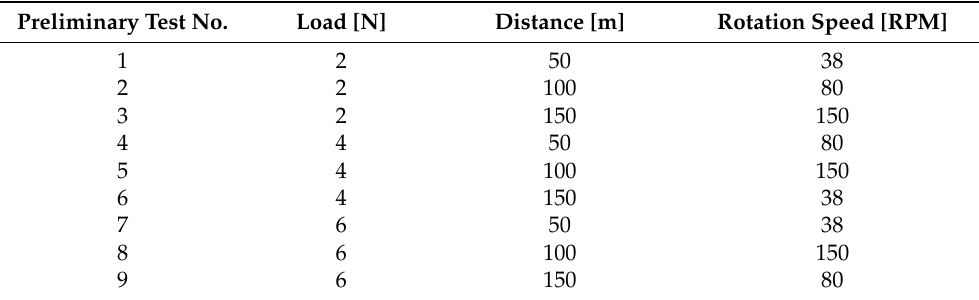
Table 2. Orthogonal table listing the input parameters of the preliminary tests. Preliminary Test